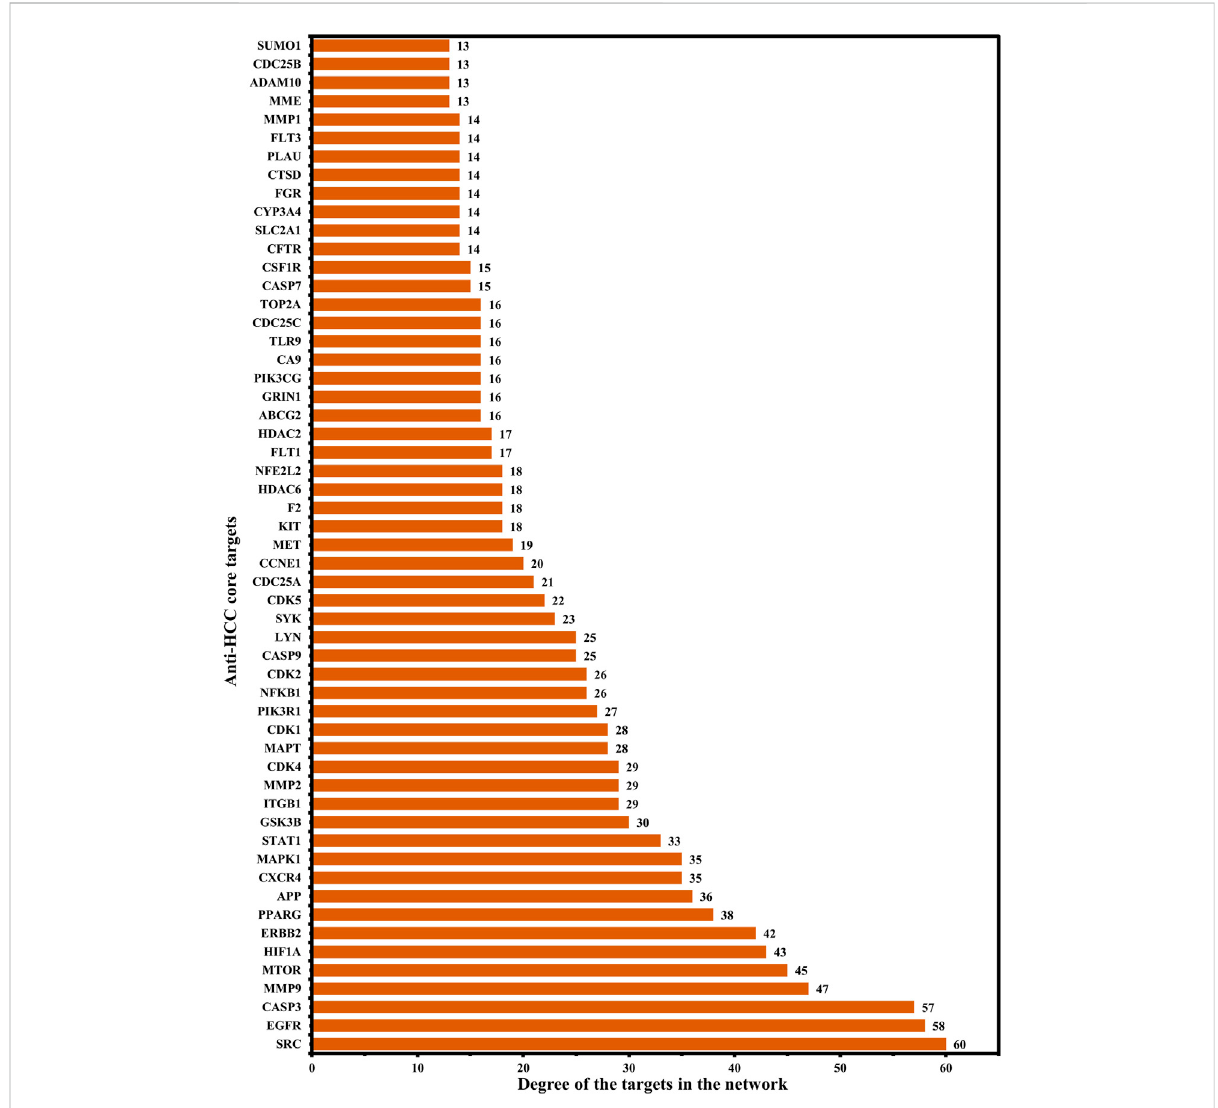
FIGURE 4 55 anti-HCC core targets in hub network ranked by DC > 12.84 (DC = Degree